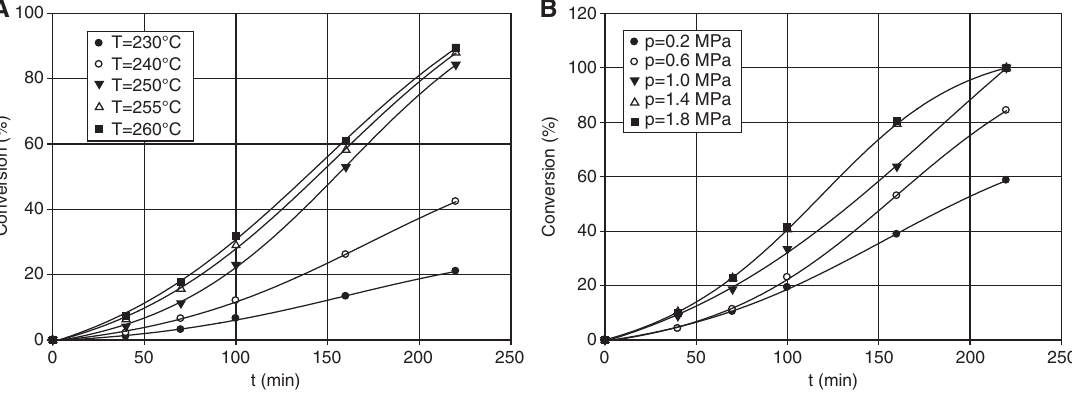
Figure 1 The conversion of SA in time varying temperature (A) and hydrogen pressure (B).